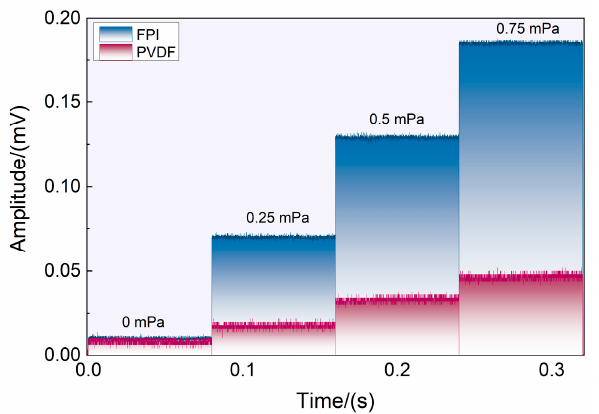
Figure 6. The output of the lock amplifier of the piezoelectric and FPI effects at different sound pressure levels.